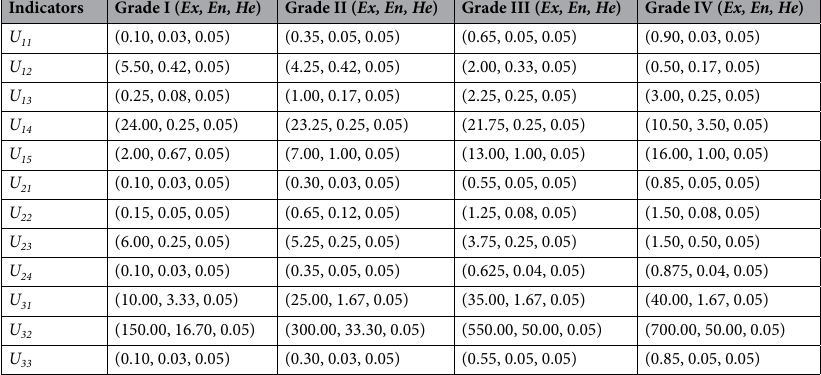
Table 2. Numerical characteristics of the cloud model for an index of coal spontaneous